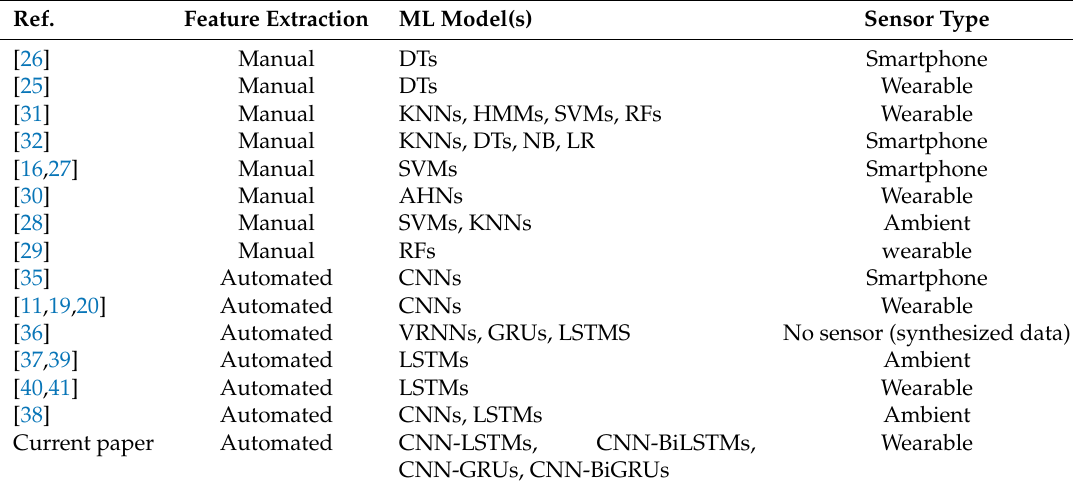
Table 1. Summary of findings in the related